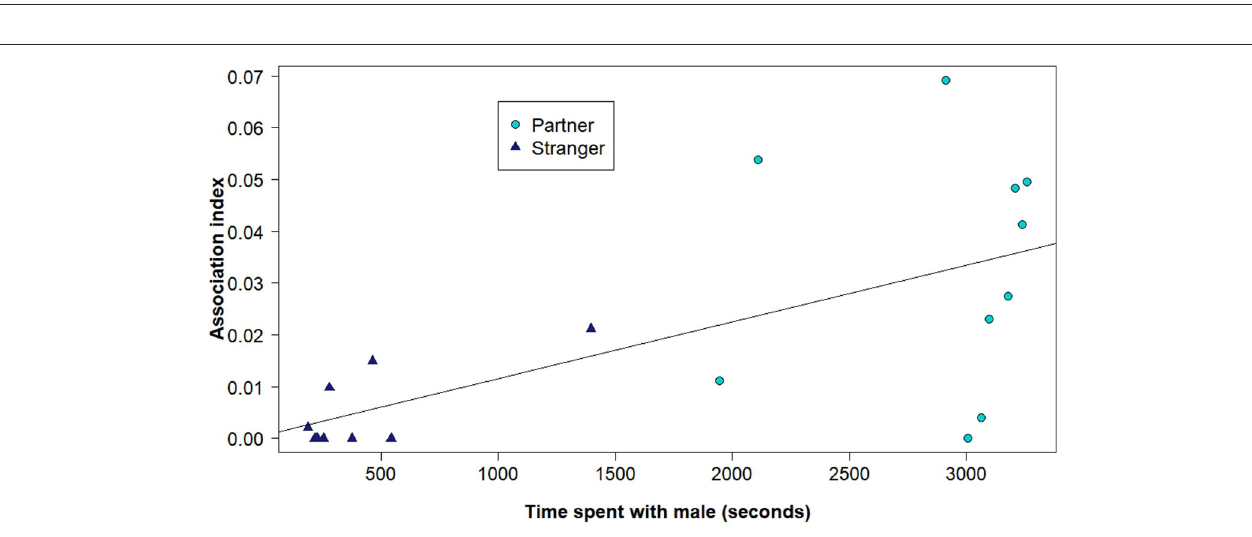
FIGURE 2 | The number of seconds that female prairie voles ( n = 10) in each trial spent on the three sides of the partner preference arena: middle of the arena, potential partner, and potential stranger (with a possible maximum of 3,600s). Note that trial number refers to the order trials were conducted during the field season.